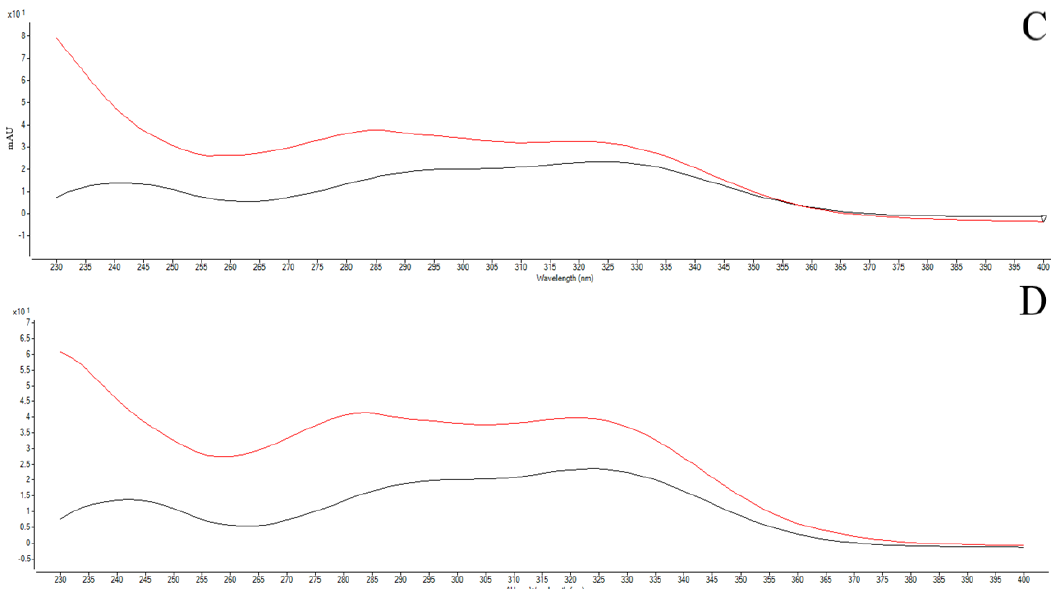
Figure 4. Superposition of the spectra of the patterns and substances found in the crude extract and microparticle. ( A ) In red spectrum is the standard of gallic acid and black spectrum refers to the gallic acid in crude extract. ( B ) In red spectrum is the standard of gallic acid and black spectrum refers to the gallic acid in microparticle. ( C ) In red spectrum is the standard of caffeic acid and black spectrum refers to the caffeic acid in crude extract. ( D ) In red spectrum is the standard of caffeic acid and in black spectrum refers to the caffeic acid in the microparticle.